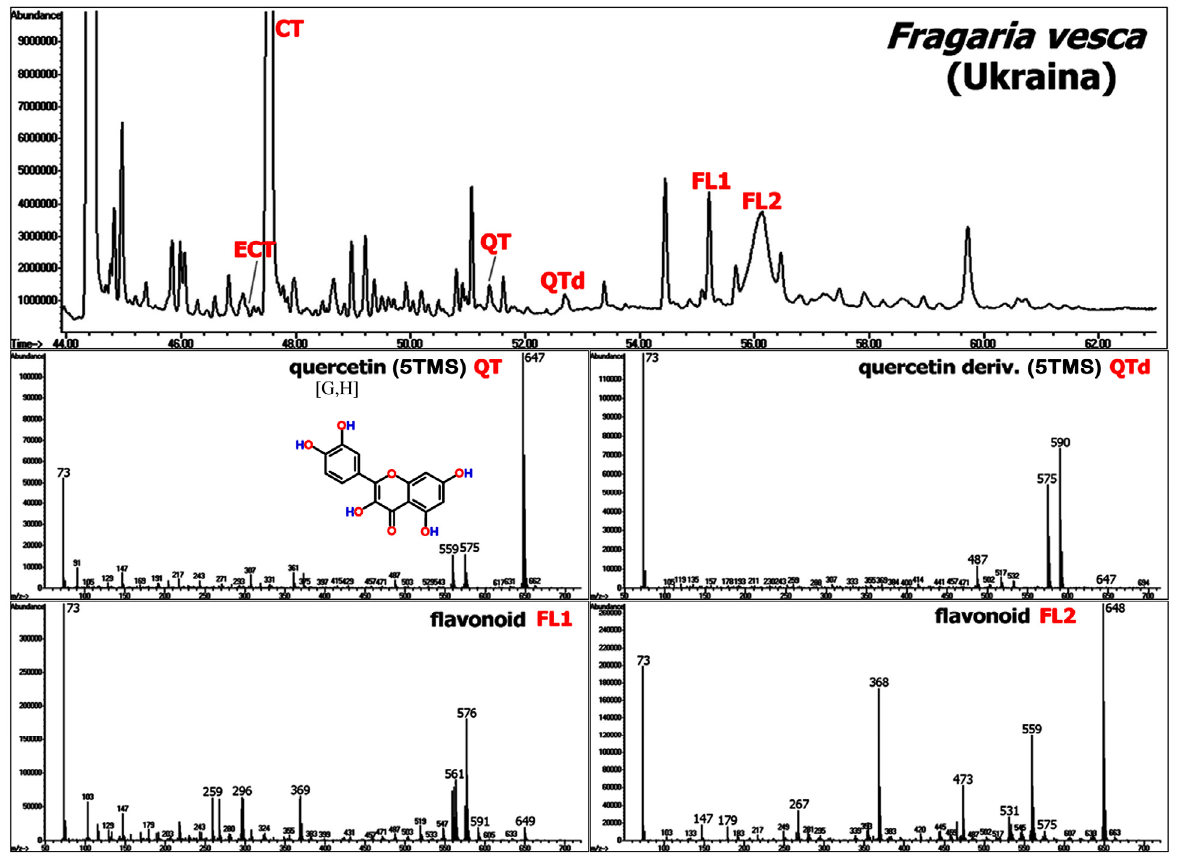
Figure 9. The upper figure shows a chromatogram (TIC), cut from the analysis of a strawberry leaf sample ( Fragaria vesca L., genotype “Ukraina”). Several MS spectra of TMS derivatives of flavonoids such as quercetin (5TMS) (QT), quercetin derivative (5TMS) (QTd), and other flavonoid structures (FL1 and FL2) are depicted below. CT = catechin (5TMS) and ECT = epicatechin (5TMS). MS spectra of CT, ECT and QT can be found